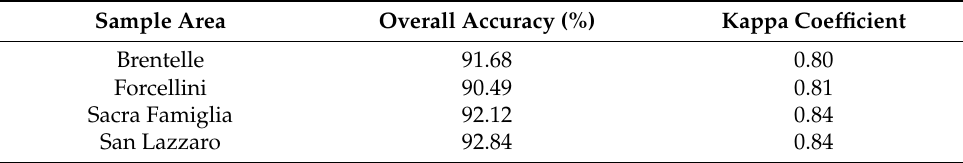
Table 8. Overall accuracy and kappa coefficient in the four sample areas.